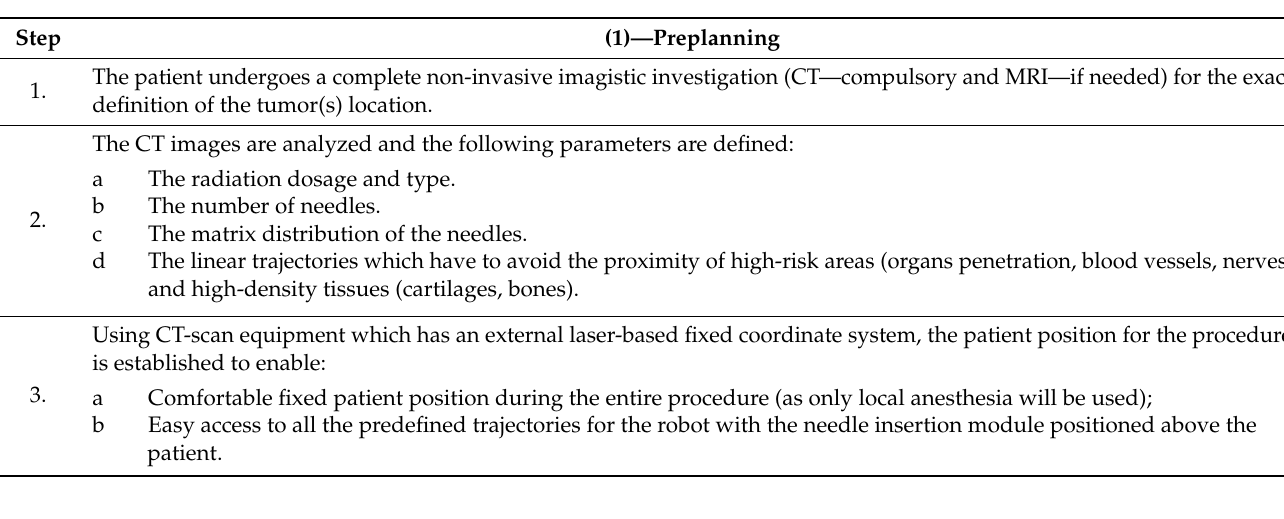
Table 3. The medical protocol for robotic assisted brachytherapy.